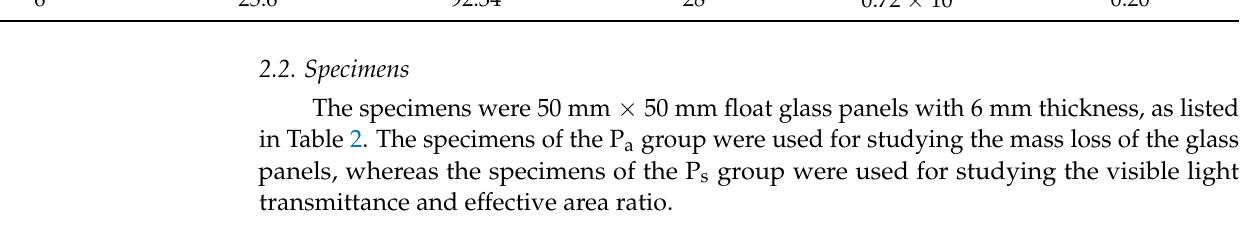
Table 2. Specimens of the glass